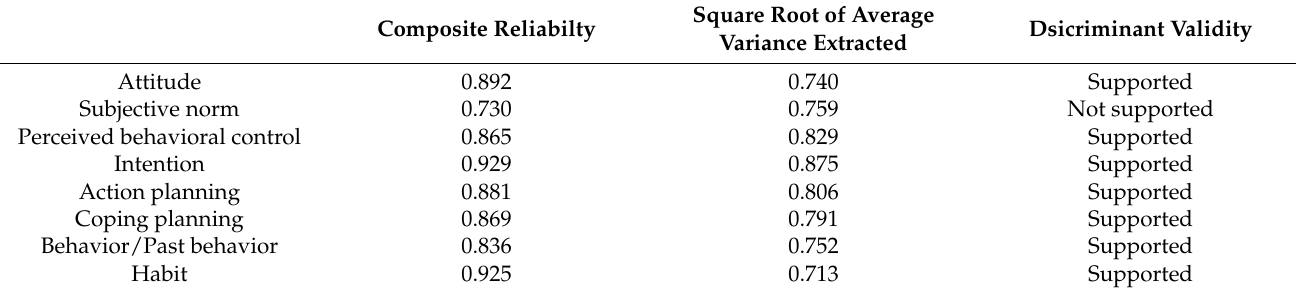
Table 3. Discriminant Validity of Study Constructs (N =